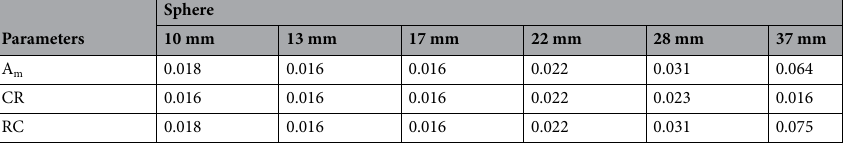
Table 2. The significant difference in 6 spheres among 4 reconstruction methods (P value). All P values were generated from Kruskal Wallis H test among the four reconstruction algorithms.